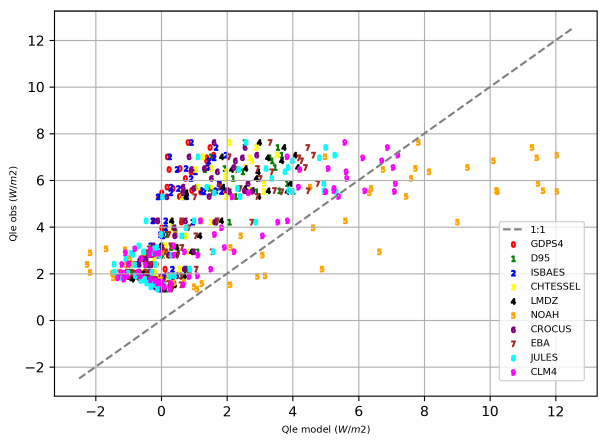
Figure 10. Scatterplot of latent heat flux simulated ( x axis) and measured ( y axis). The dashed gray line represents the 1 : 1